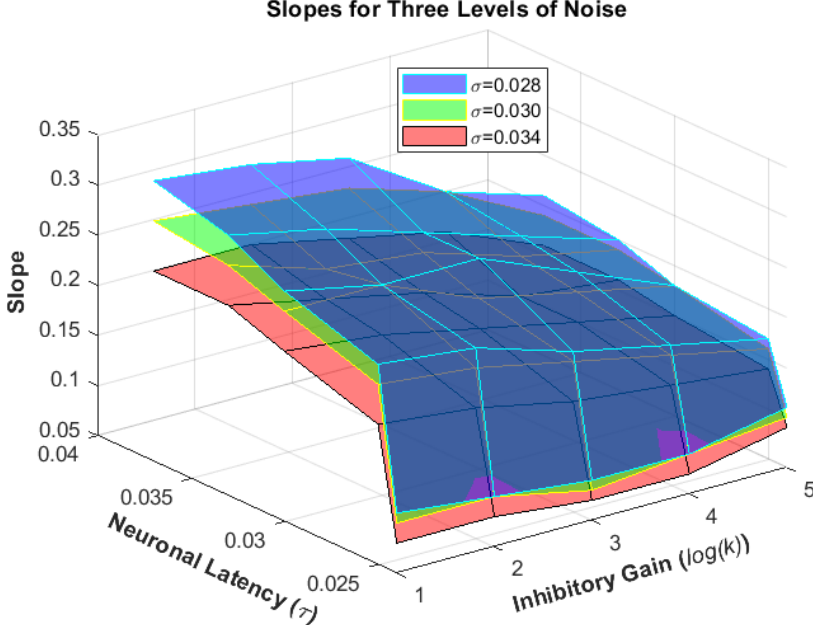
Figure 5. The resulting psychometric function slopes when running the model for exemplary ranges of neuronal latency ( τ = 0.024, 0.025, 0.03, 0.033, 0.037 s) and inhibitory gain ( k = 2, 4, 8, 16, 32) for three noise levels ( δ = 0.028, 0.030,0.034 )